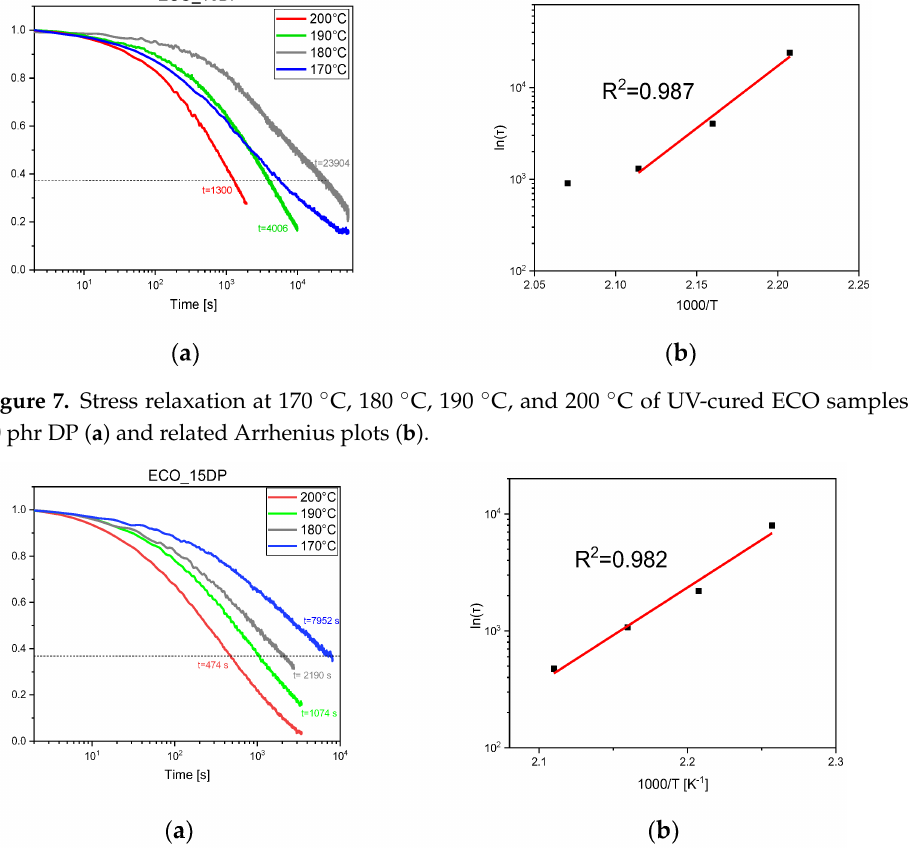
Figure 8. Stress relaxation at 170 ◦ C, 180 ◦ C, 190 ◦ C, and 200 ◦ C of UV-cured ECO samples with 15 phr DP ( a ) and related Arrhenius plot ( b